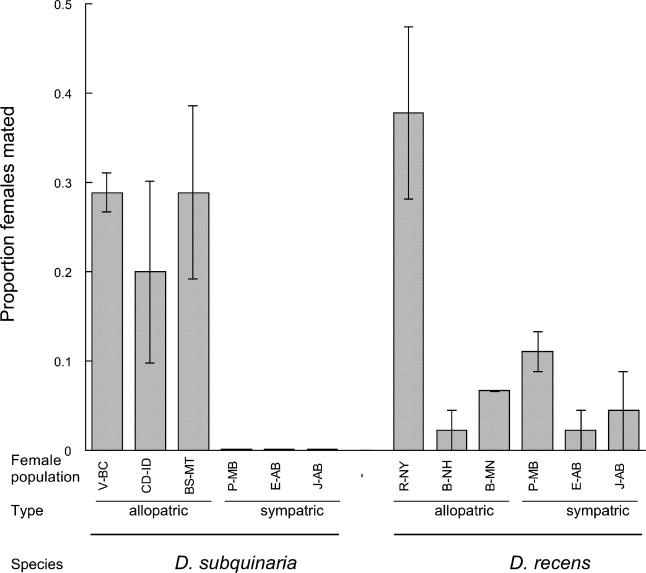
Proportion of Females That Mated with Heterospecific Males in the No-Choice TrialsMeans ± standard error among replicate trials. Females are organized by species, population type (sympatric or allopatric within species), and population within type. Population labels from Table 1, with S- or R- prefix deleted. The populations correspond with the sites in Figure 1 as follows: V-BC, 4; CD-ID, 6; BS/MT, 9; P/MB, 14; E-AB, 11; J-AB, 10; R-NY, 20; B-NH, 17; B-MN, 23.